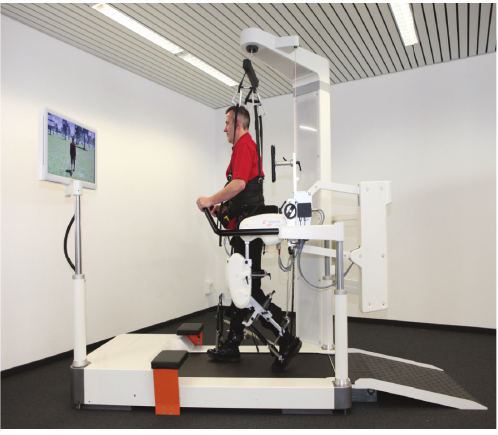
Figure 2: Lokomat system (picture courtesy of Hocoma).